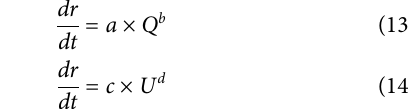
Frontiers in Materials |